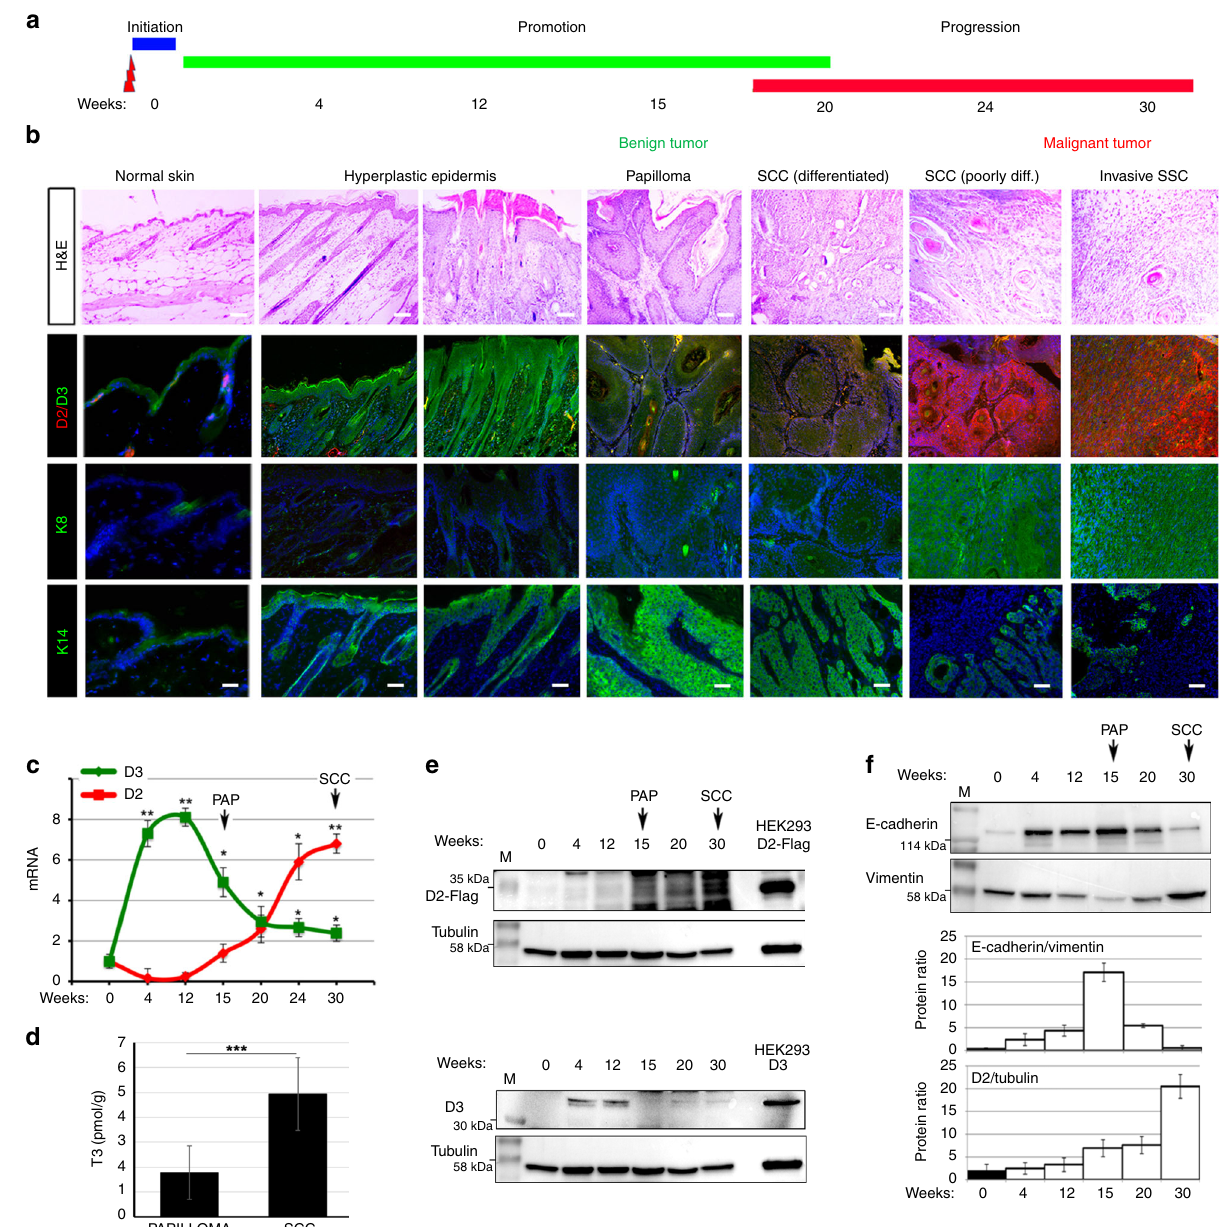
Fig. 1 D2 and D3 are dynamically expressed during SCC tumor initiation and progression. a Schematic representation of the two-step carcinogenesis experiment. b Representative H&E, D2/D3 co-staining, and K8 and K14 staining of DMBA-TPA-treated skins for the indicated weeks. Images represent tumors of one of eight different D2-Flag mice analyzed for each time point ( n = 8). Scale bar represents 200 μ m. c mRNA levels of D2 and D3 were measured in progressive DMBA-TPA-treated skins as indicated in a and b , by real-time PCR analysis ( n = 8). d Intracellular T3 was measured as indicated in the “ Methods ” section in dorsal skin tissues from mice treated with DMBA-TPA for 15 (PAP) and 30 (SCC). e Western blot analysis of D2-Flag and D3 expression from skin lesions of D2-3xFlag mice treated with DMBA-TPA for the indicated times ( n = 8). HEK293 cells transfected with D2-Flag or D3 served as D2 and D3 controls, respectively. Arrows indicate the papillomas (PAP) and SCC tumors. f Western blot analysis of E-cadherin, vimentin, and tubulin in the same samples as in e . Quanti fi cation of the single protein levels versus tubulin levels and the E-cadherin/vimentin ratio is represented by